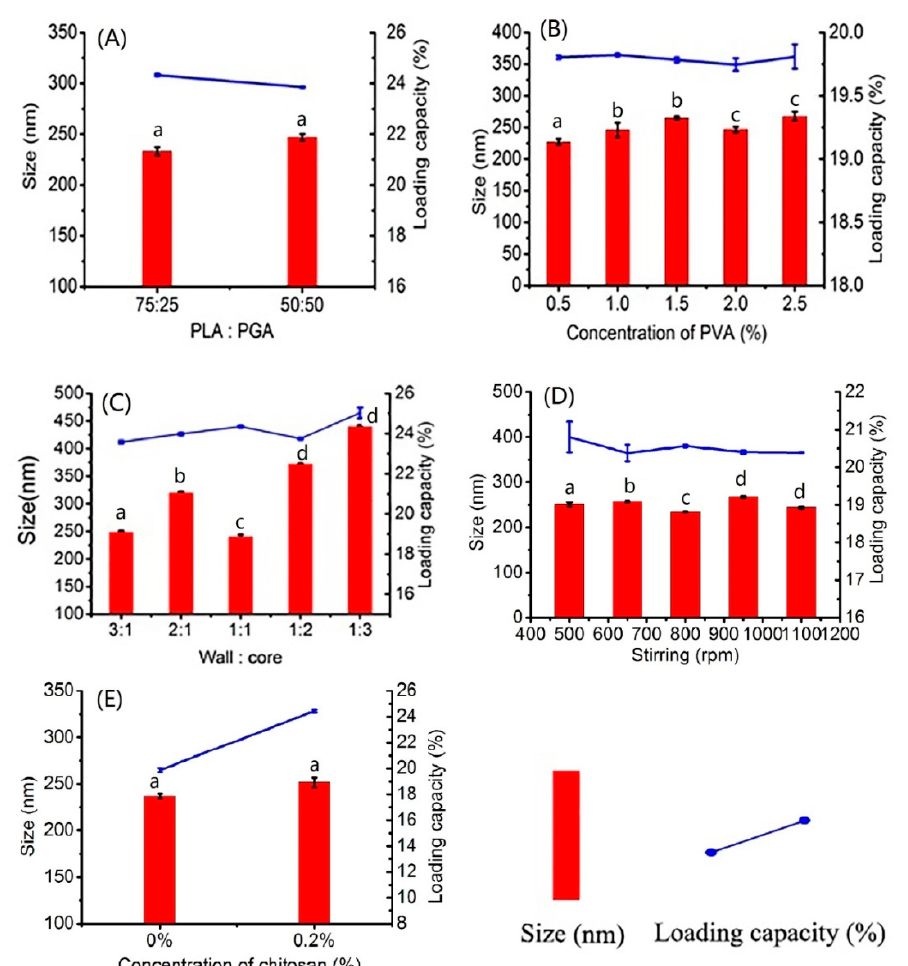
Figure 1. ( A ): e ff ect of PLGA (PLA:PGA) on the particle size and the loading capacity, ( B ): e ff ect of PVA Figure 1. A : effect of PLGA (PLA:PGA) on the particle size and the loading capacity, B : effect of PVA concentration on the particle size and the loading capacity, ( C ): e ff ect of wall to core on the particle size concentration on the particle size and the loading capacity, C : effect of wall to core on the particle size and the loading capacity, ( D ): e ff ect of stirring on the particle size and the loading capacity, ( E ): e ff ect of and the loading capacity, D : effect of stirring on the particle size and the loading capacity, E : effect of chitosan concentration on the particle size and the loading capacity. Di ff erent lowercase letters indicate chitosan concentration on the particle size and the loading capacity. Different lowercase letters a significant di ff erence by one-way analysis of variance (ANOVA) ( p < indicate a significant difference by one-way analysis of variance (ANOVA) ( p < 0.05).